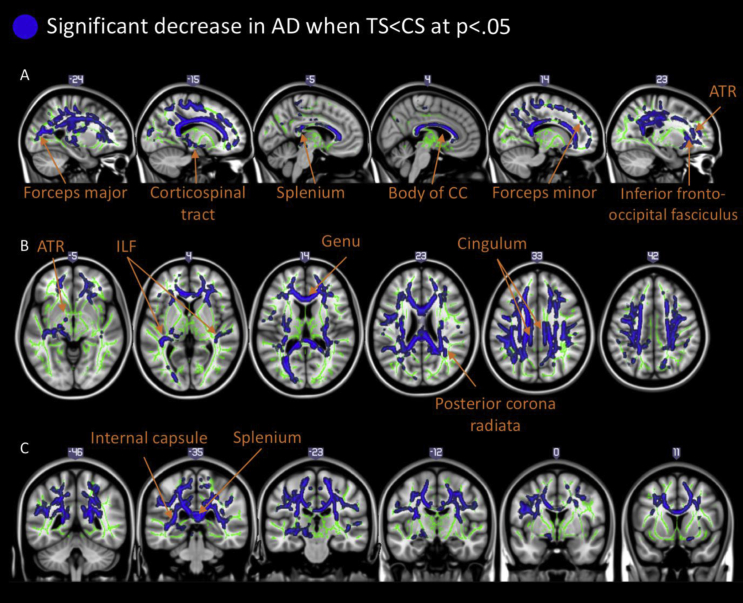
Illustrates key tracts exhibiting significant decreases in AD (p < .05 corrected for multiple comparison). Differences are projected onto the mean WM skeleton (green) and the MNI 152 template. Top panel, A: sagittal images showing significant tracts. Coordinate numbers are X coordinates in MNI space. Middle panel, B: axial images showing significant tracts. Coordinate numbers displayed are Z coordinates in MNI space. Bottom panel, C: images showing significant tracts. Coordinate numbers are Y coordinates in MNI space. Abbreviations, ATR = anterior thalamic radiation. CC = corpus callosum. ILF = inferior longitudinal fasciculus.